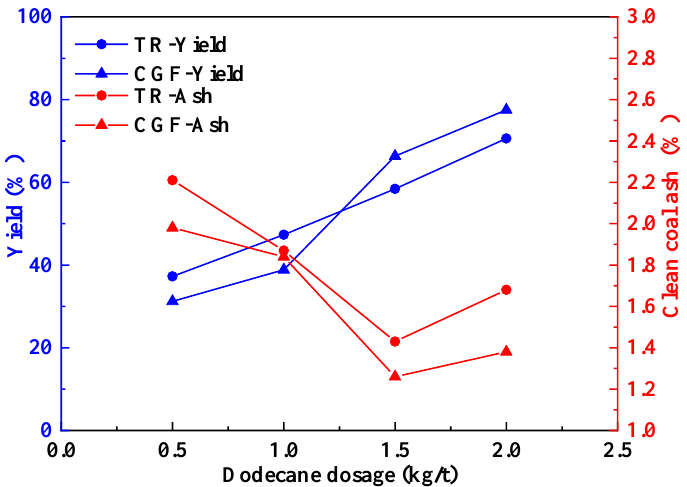
Figure 5. Flotation results of collector gasification flotation method and traditional flotation method under different collector dosages.